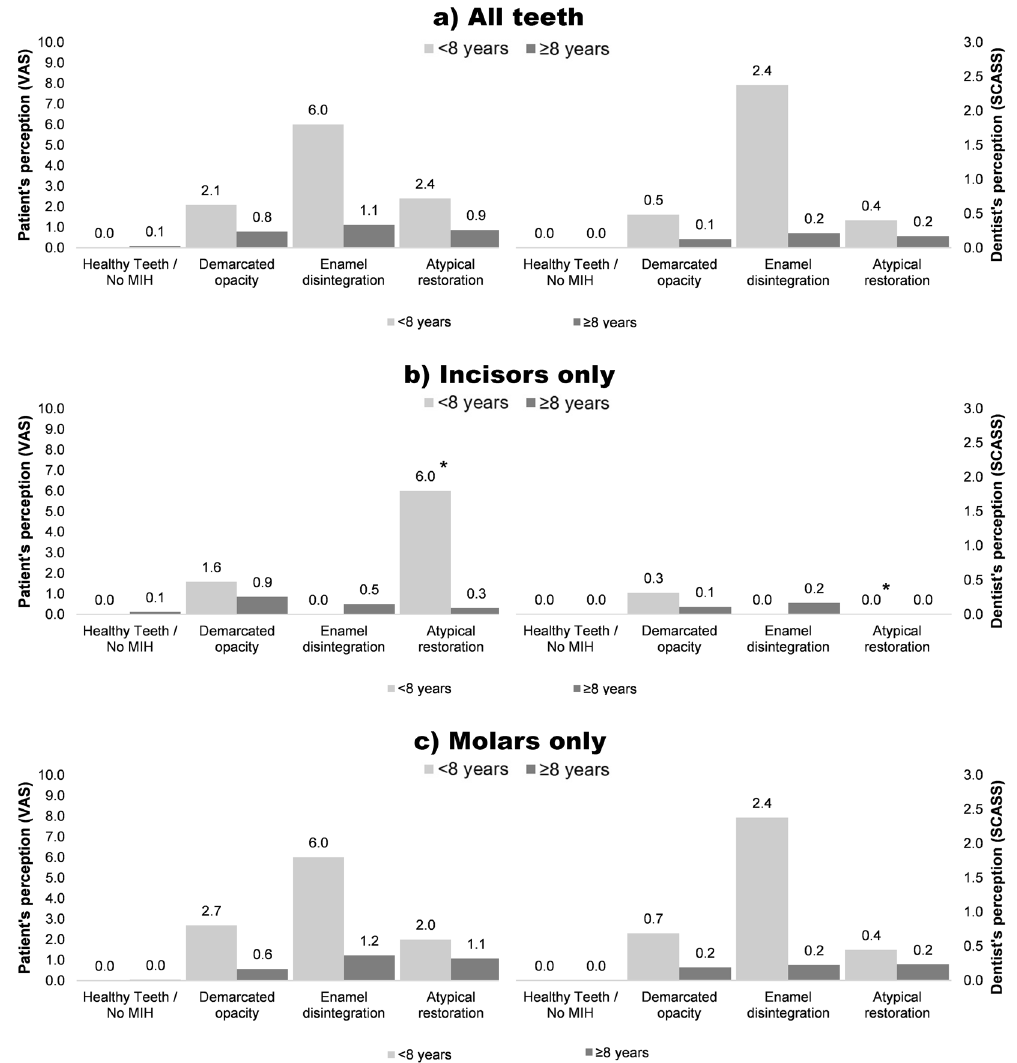
Figure 2. MIH-related hypersensitivity plotted according to the type of tooth in younger (< 8 years) and older (≥ 8 years) children. *Mean value is based on data from only one